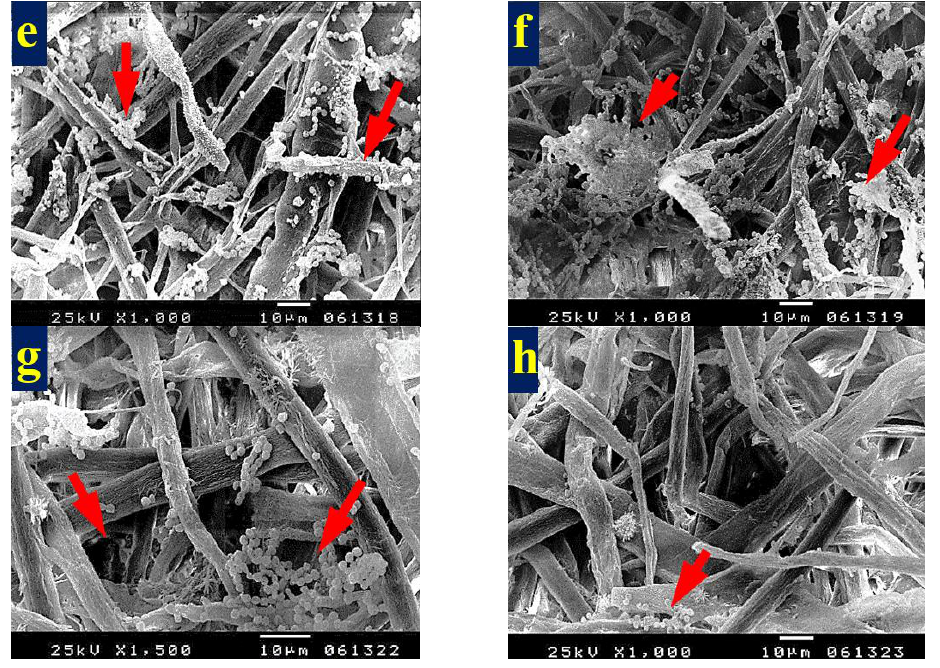
Figure 8. SEM images of M. sinclairii WB pulp paper produced with/without HeOE additives and inoculated with A. flavus : ( a ) without HeOE additives; ( b ) with 10% DMSO; arrows in ( a , b ) indicate fungal mycelia and spores prevalence and penetration especially on sample fibers; ( c ) with M. azedarach HeOE at 1%; ( d ) with M. grandiflora HeOE at 1%; arrows in ( c , d ) indicate the intensity of the fungal mycelia growth and spores diffusion; ( e ) with M. azedarach HeOE at 3%; arrows in ( e , f ) indicate spores diffusion in and between fibers; ( f ) with M. grandiflora HeOE at 3%; ( g ) with S. alba HeOE at 5%; ( h ) with M. grandiflora HeOE at 5%, where arrows in ( g , h ) indicate a marked decrease in the density of the fungal mycelia growth and decrease in the fungal spores based on type and concentration of added HeOEs.